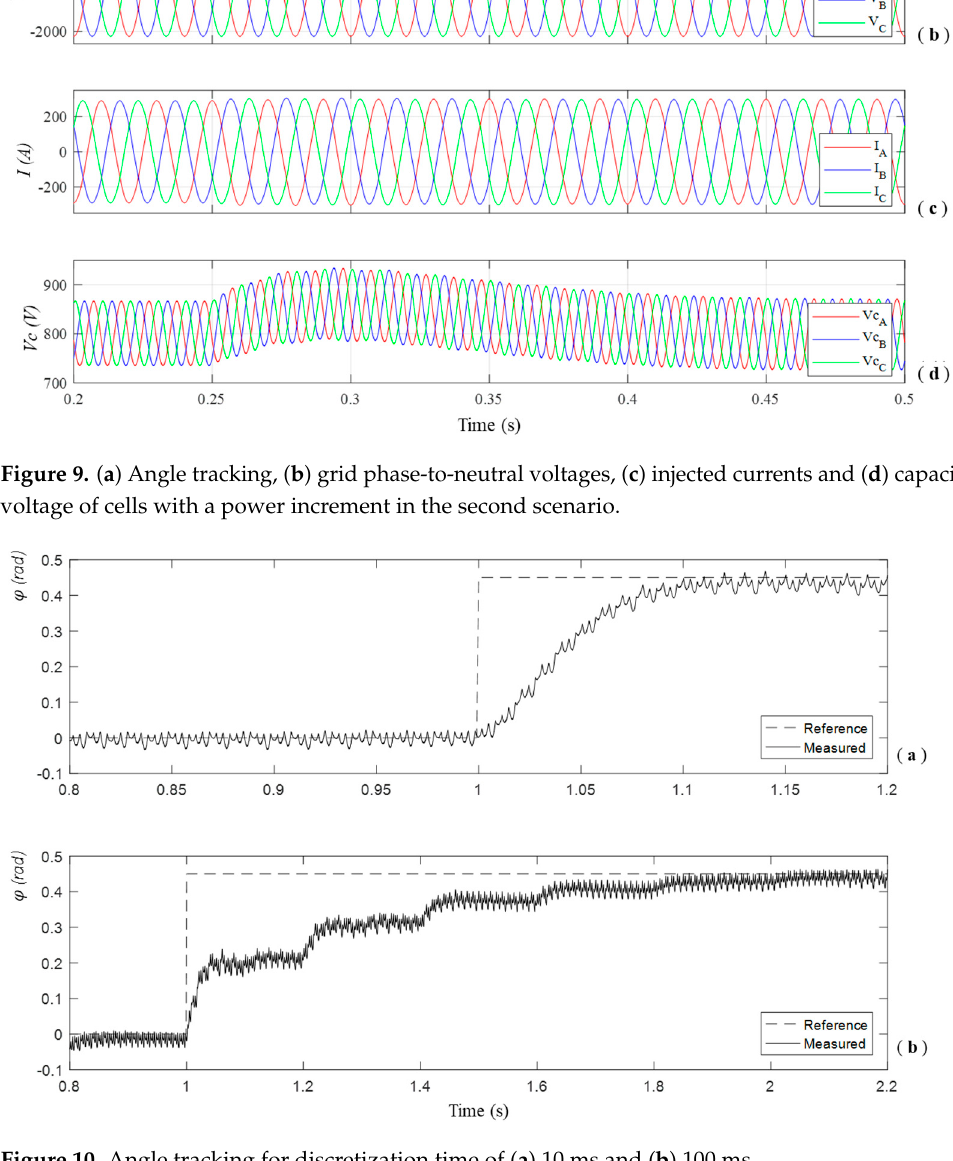
Figure 10. Angle tracking for discretization time of ( a ) 10 ms and ( b ) 100